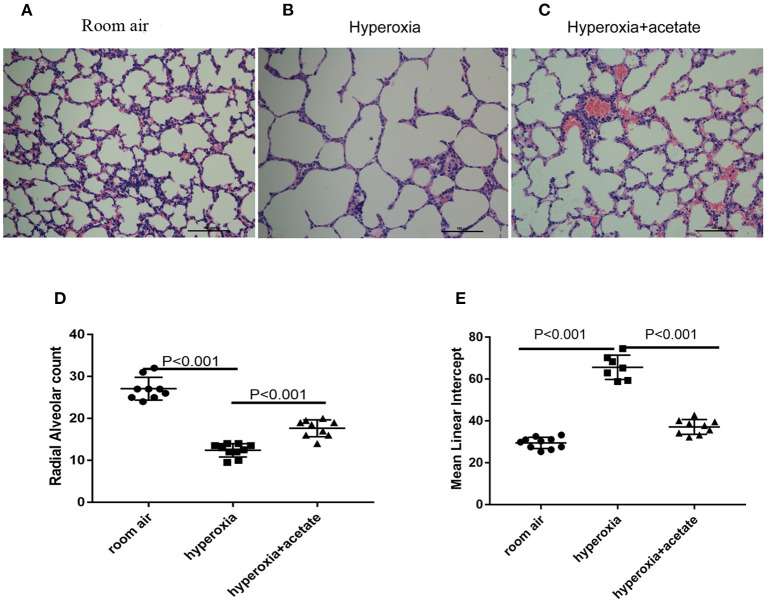
Acetate attenuates morphological changes. Hyperoxia exposure led to marked alveolar simplification as shown by H&E staining and by RAC and MLI assessment. Acetate treatment improved the hyperoxia-induced impairment of alveolar growth. (A–C) Representative H&E staining (light microscopy, ×200) of lung tissue slides from each group. Scale bars = 100 μm. (D) Semiquantitative pathological determination of RAC in lung tissues. (E) Semiquantitative pathological determination of MLI in lung tissues. The values represent the mean ± SD; n = 6 mice/group.